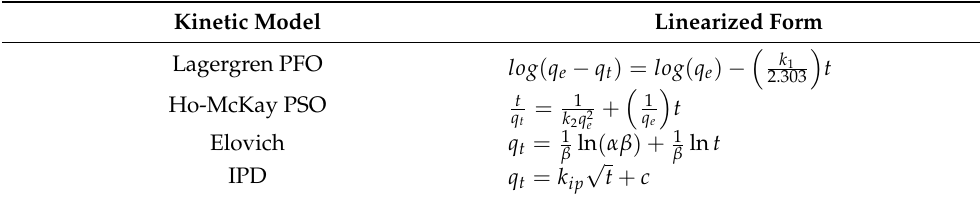
Table 1. The linearized forms of the tested kinetic